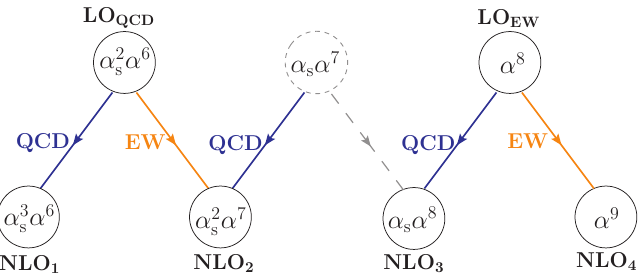
Figure 1: Perturbative orders contributing at LO and NLO to ttW production in the three-charged-lepton decay channel.